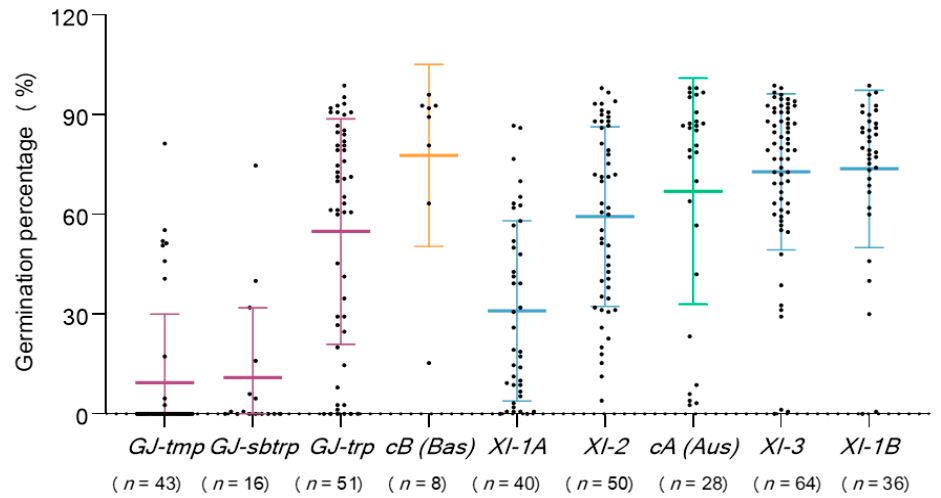
Figure 6. Scatter dot plot of seed germination percentage at temperature 42 °C and relative humidity 88% for 20 days in different subgroups.